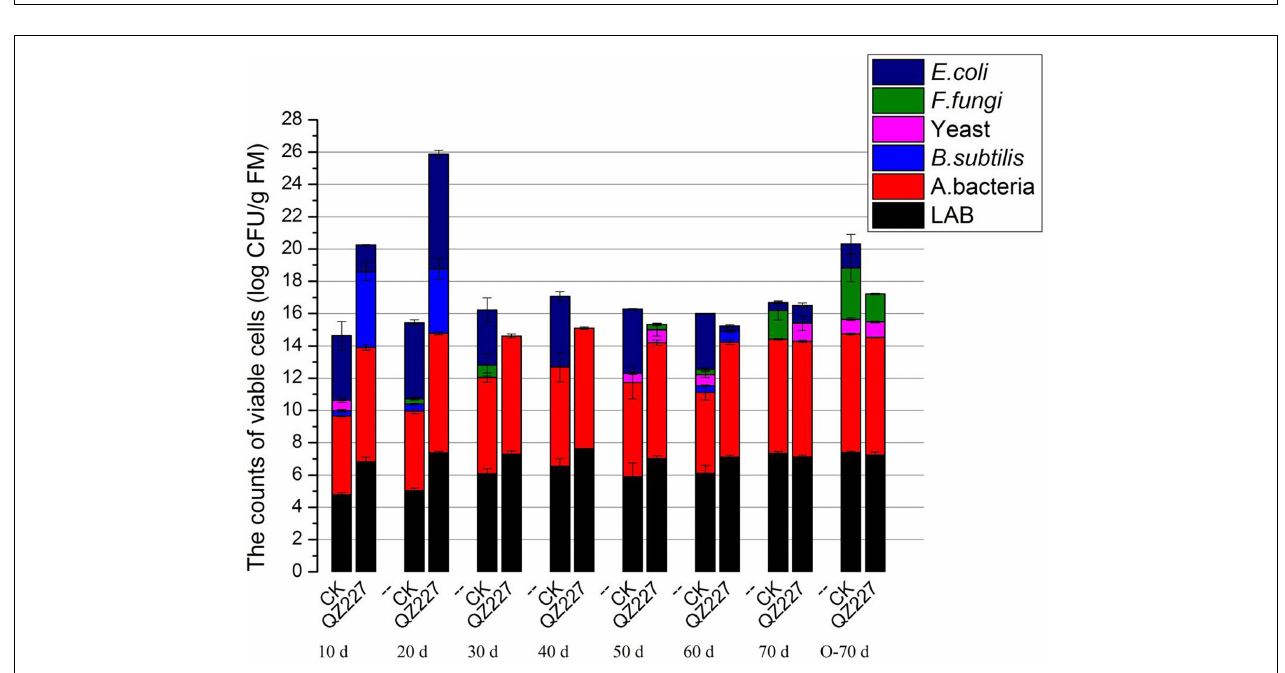
FIGURE 1 | The pH variations during the fermentation process. Ns, not significant, **, very significant, 0.001 < P ≤ 0.01.